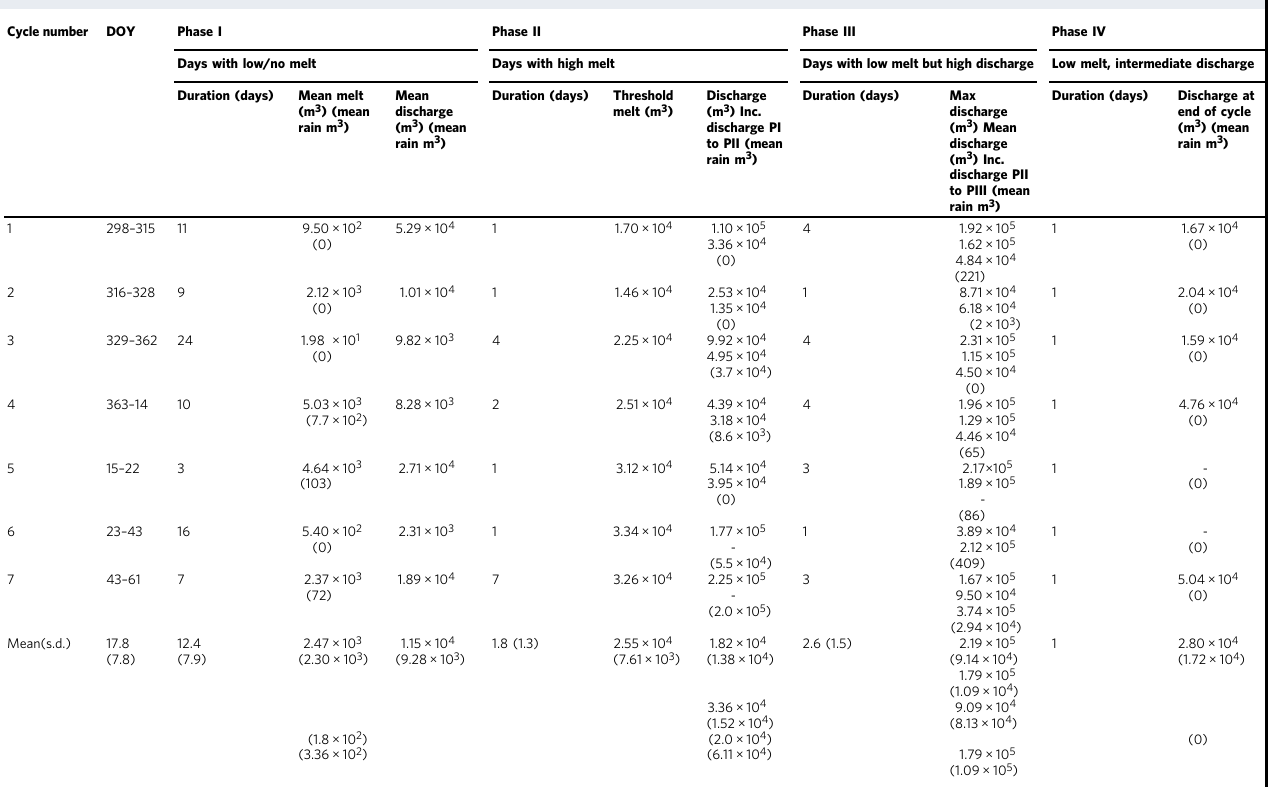
Table 1 Daily properties of the discharge cycles during winter